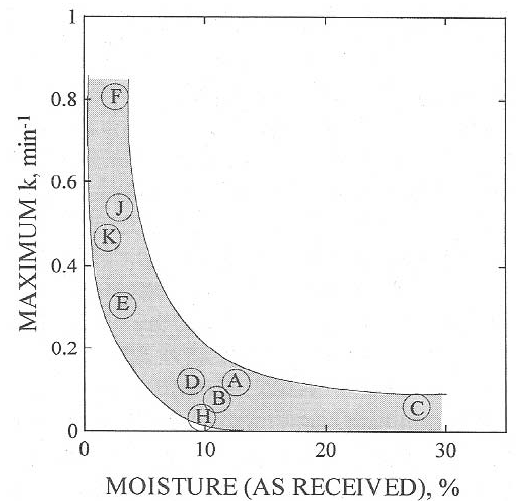
Fig. 1 Maximum flotation rate constants (salt flotation in 0.5M NaCl) versus moisture content for U.S. western coals (after Fuertenau et al., 1983) 5) .